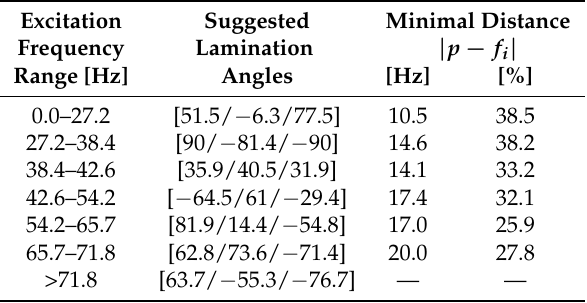
Table 5. Suggested lamination angles for different excitation force